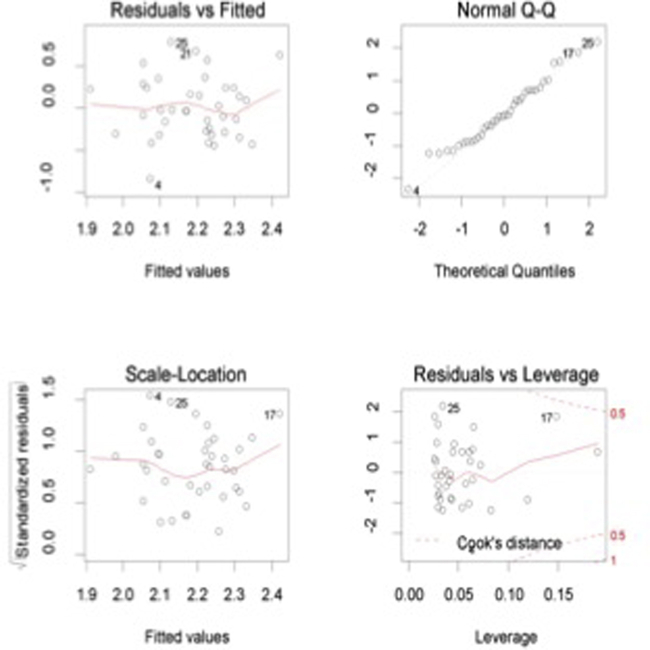
Survival analysis. Kaplan–Meier curves showing overall survival (OS) of patients relative to baseline cfDNA concentration quartiles. The continuous line presents patients with baseline cfDNA in the lower quartile (<89 pg/μL, N = 10), the dashed line the combined central quartiles (≥89 pg/μl and <262.9 pg/μL, N = 22), and the dotted line the upper quartile (≥262.9 pg/μL N = 11).